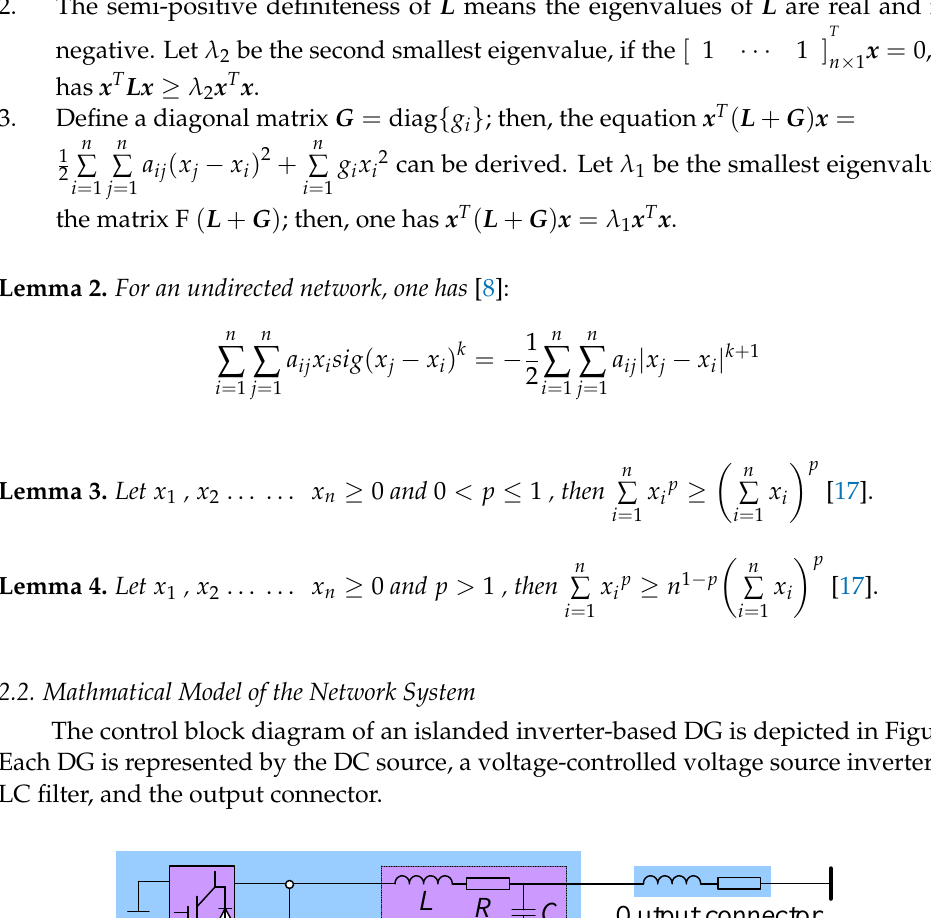
where V i and ω i are the output voltage and frequency, respectively, which are provided for the internal voltage and current dual-closed loop controller; V 0 i and ω 0 i are the primary reference, which are determined at the secondary control layer; m pi and m qi are the